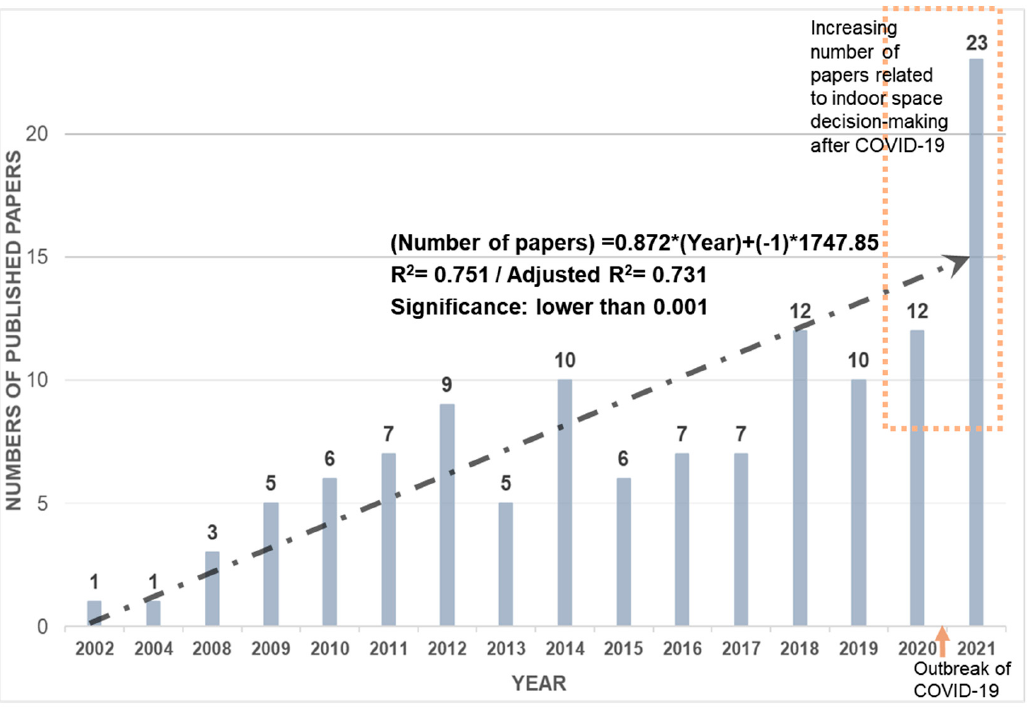
Figure 2. Number of papers published by year with regression equation. Furthermore, the authors analyzed the number of published journals, citations, and papers included in the journal. Of the 124 papers included in this study, these were published in 58 journals. Figure 3 illustrates journals publishing two or more papers, and the percentage among the 114 extracted papers is represented by blue